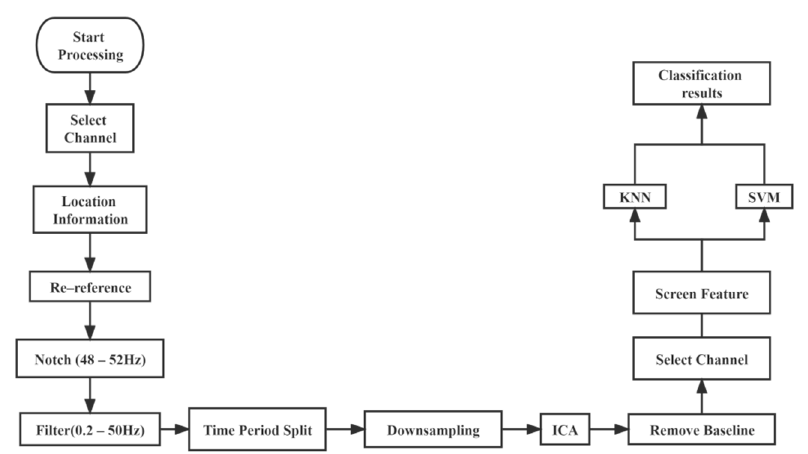
Figure 8. The flowchart for pre-processing, feature extraction and classification.